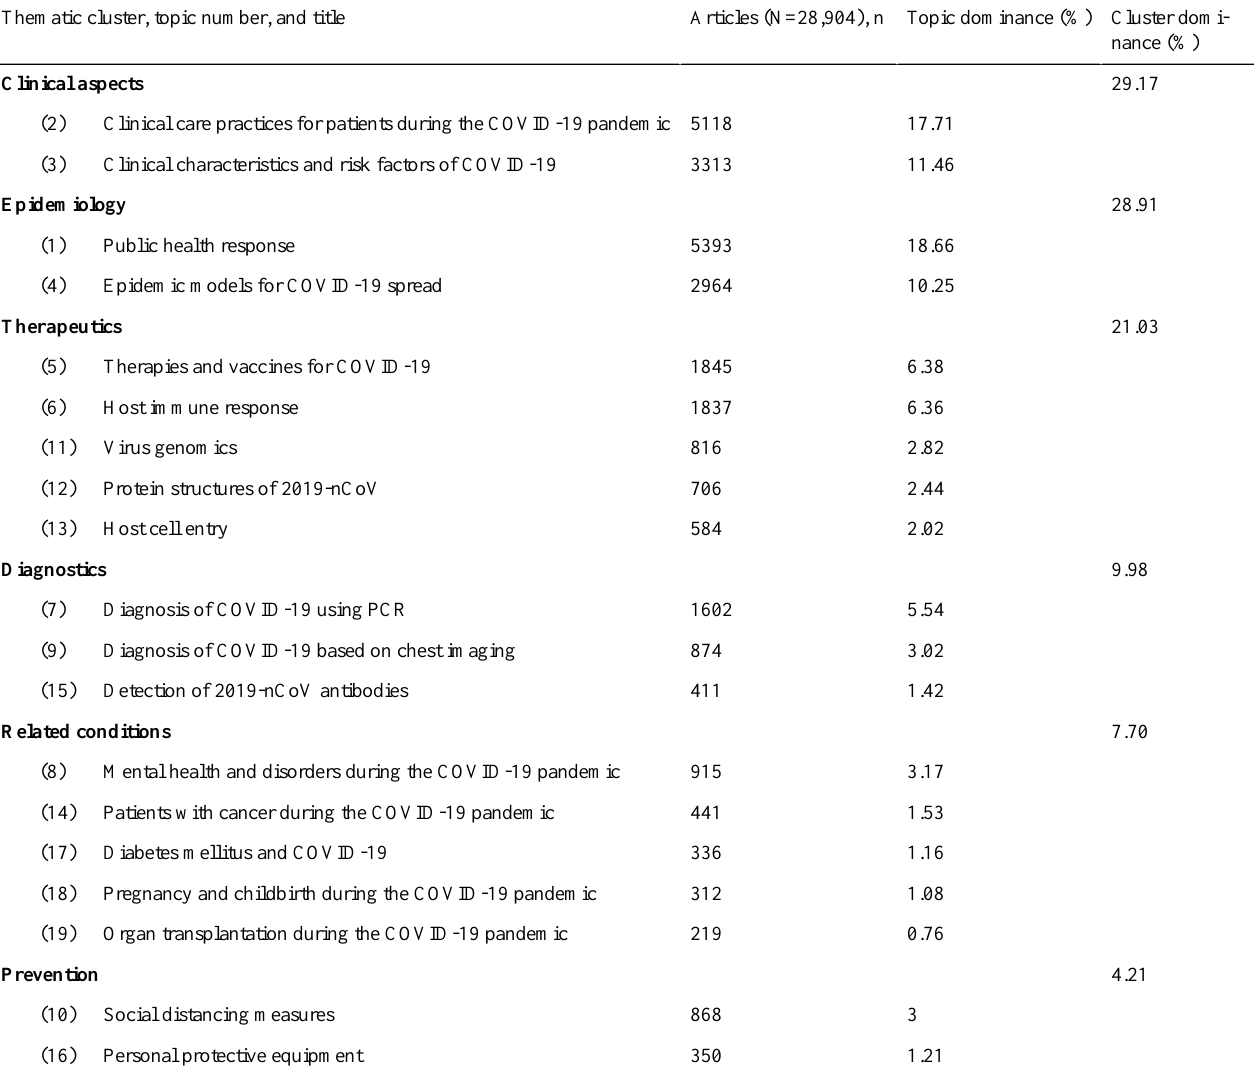
Table 6. Topics grouped by thematic cluster, including the percentage of articles by topic and cluster.